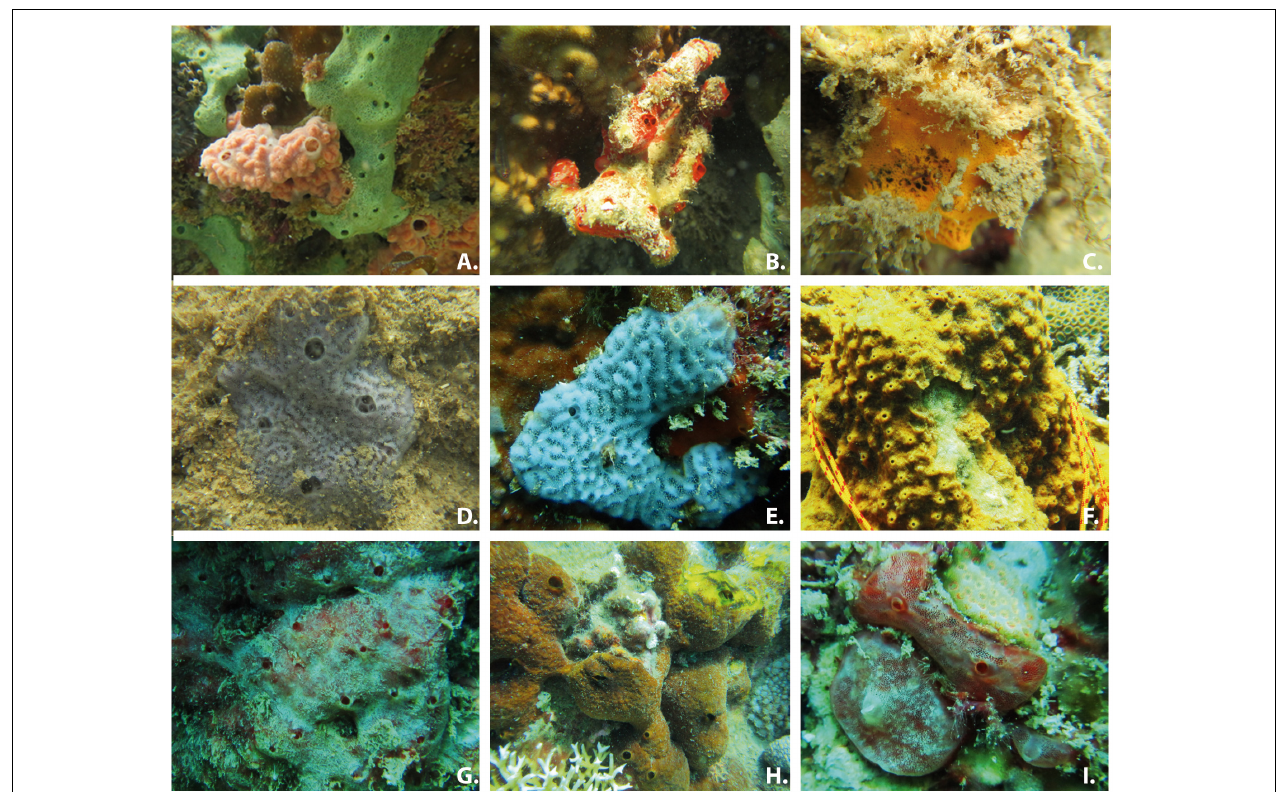
FIGURE 2 | Pictures of the most common sponges of the impacted (A–D) and the well-preserved (E–I) habitats: (A) Amphimedon paraviridis (greenish) and Clathria reinwardti (pinkish), (B) Clathria ( Isociella ) skia , (C) Mycale ( Arenochalina ) sp., (D) Amphimedon sulcata (in the impacted environment), (E) A. sulcata (in the well-preserved environment), (F) Neofibularia sp., (G) Antho ( Antho ) sp., (H) Aaptos suberitioides and (I) Monanchora